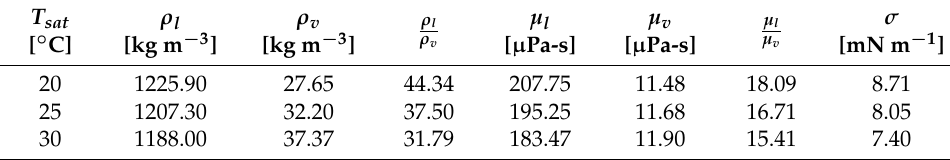
Table 2. Thermophysical properties of R134a